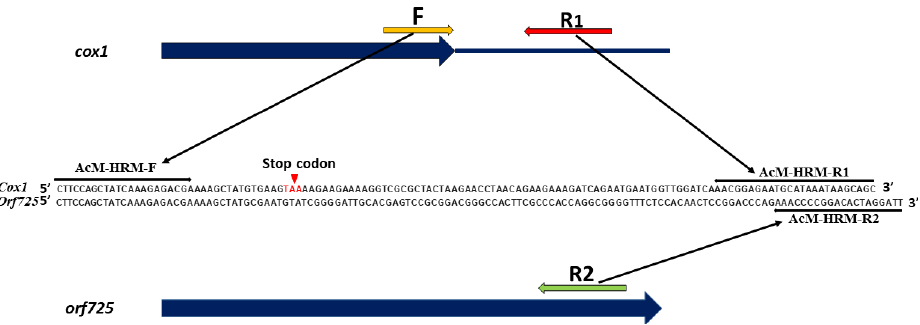
Figure 1. HRM primer annealing sites on cox1 and orf725 gene sequences. Primer binding sites are indicated by horizontal arrows. The red triangle indicates the stop codon of the cox1 gene.